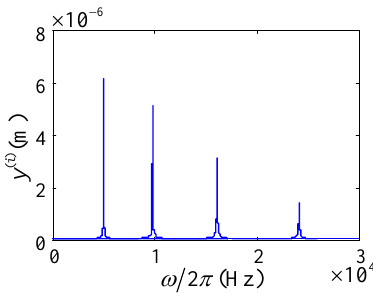
Figure 8. 3rd–6th order frequency domain response of the touch beam